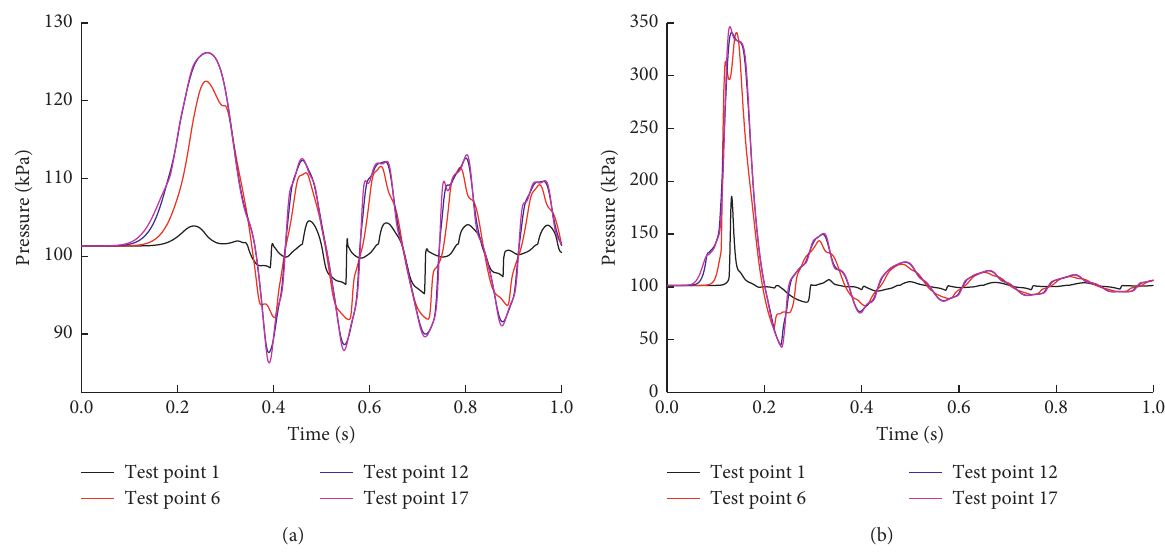
Figure 13: Curves of pressure vs. time under different gas compositions. (a) 6% CH